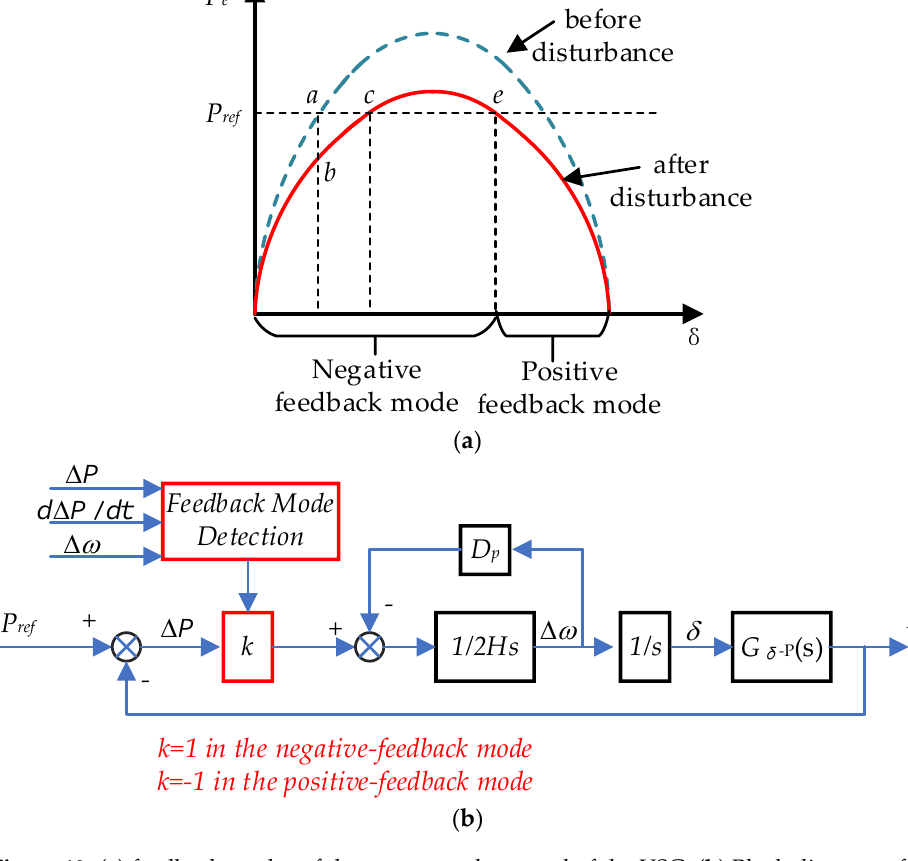
Figure 10. ( a ) feedback modes of the power-angle control of the VSG; ( b ) Block diagram of mode- adaptive control of the